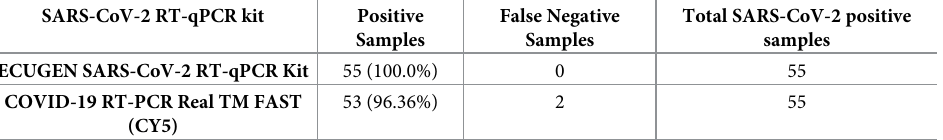
Table 1. Clinical performance of ECUGEN SARS-CoV-2 RT-qPCR and COVID-19 RT-PCR Real TM FAST (CY5) kits using TaqMan 2019-nCoV Assay Kit v1 as reference methodology (% values: sensitivity). Only SARS- CoV-2 positive samples included on the study are